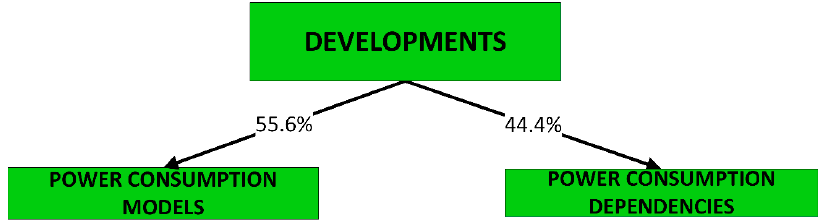
Figure 3. A top-level division of the developments, with frequency of occurrence shown as a percentage.